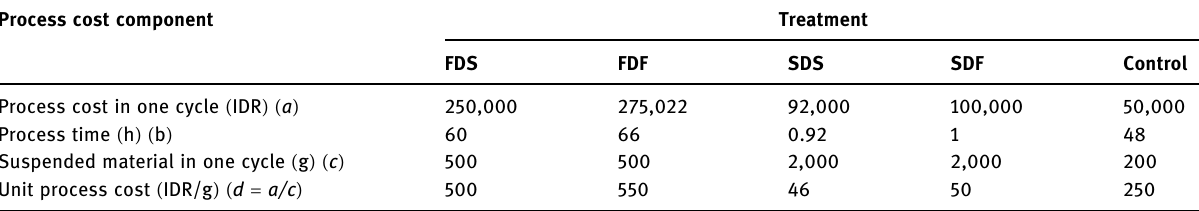
Table 2: Process cost of hydrated L. acidophilus Process cost